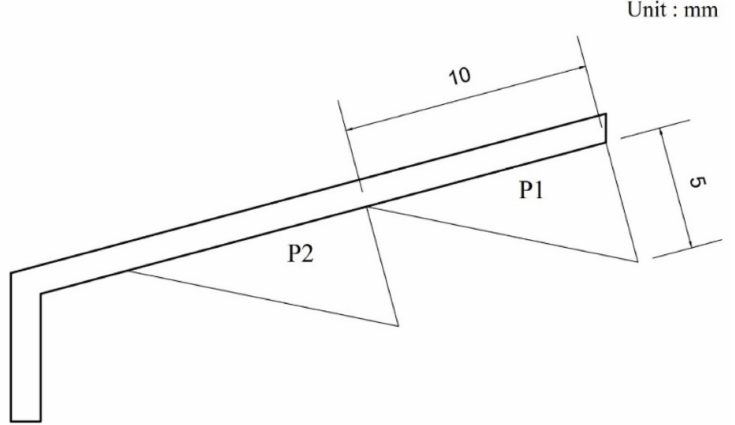
Figure 15. Schematic diagram of different actuation positions with 10 mm actuation length on inner surface (upper